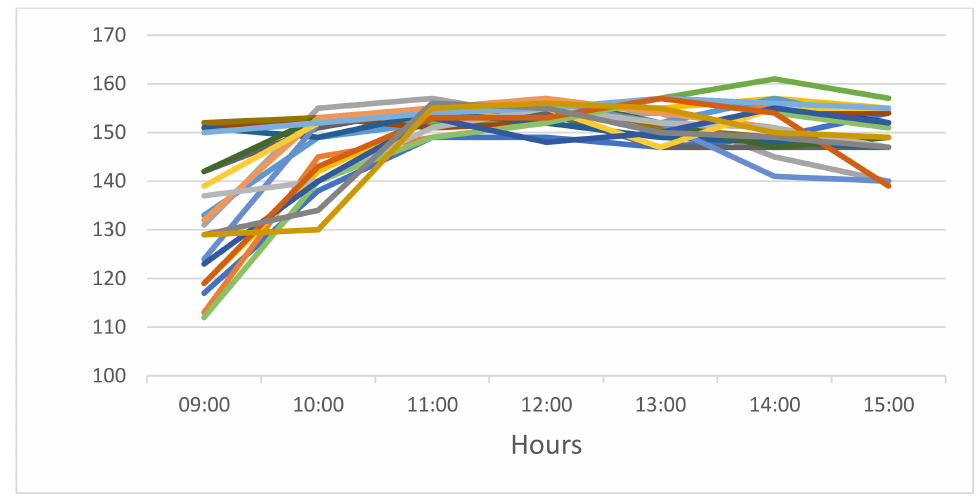
Figure 5. Hourly requests for floating licenses with each color representing a different day in